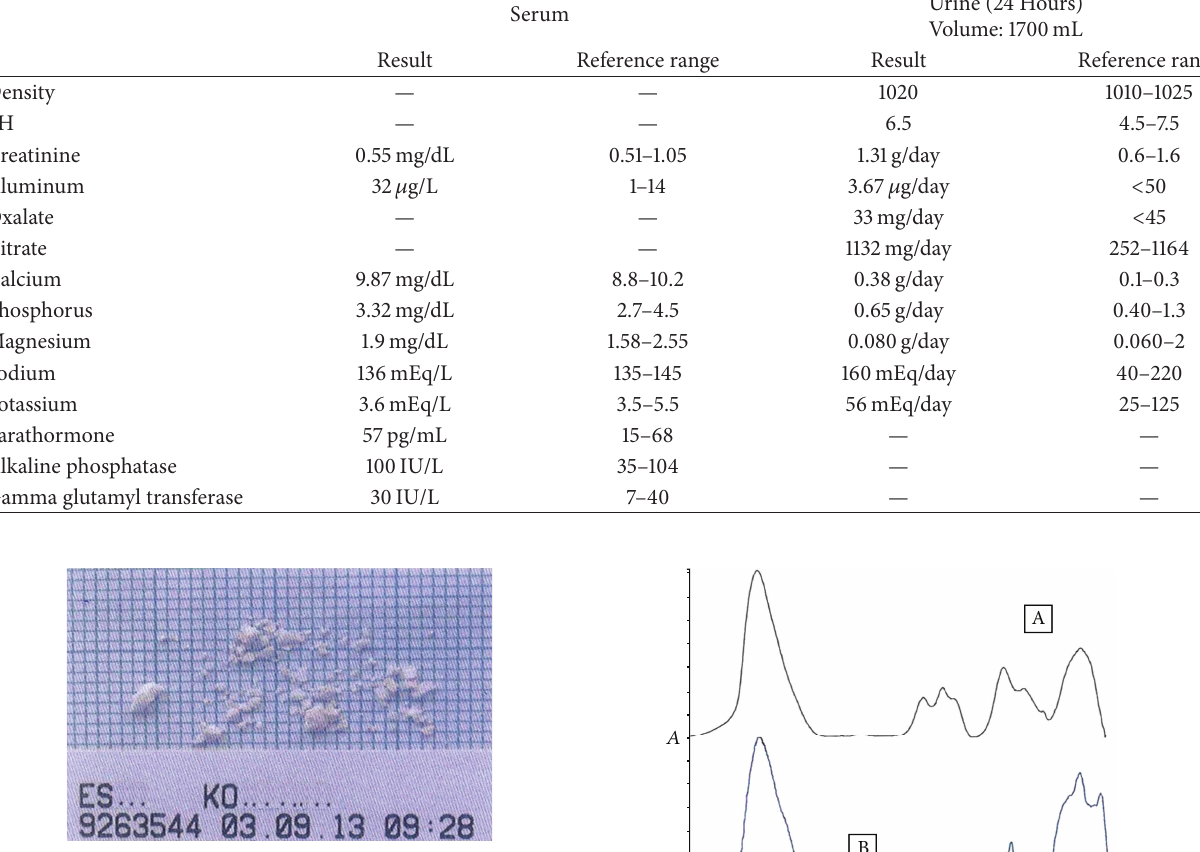
Figure 1: Four of stones broken by hand.